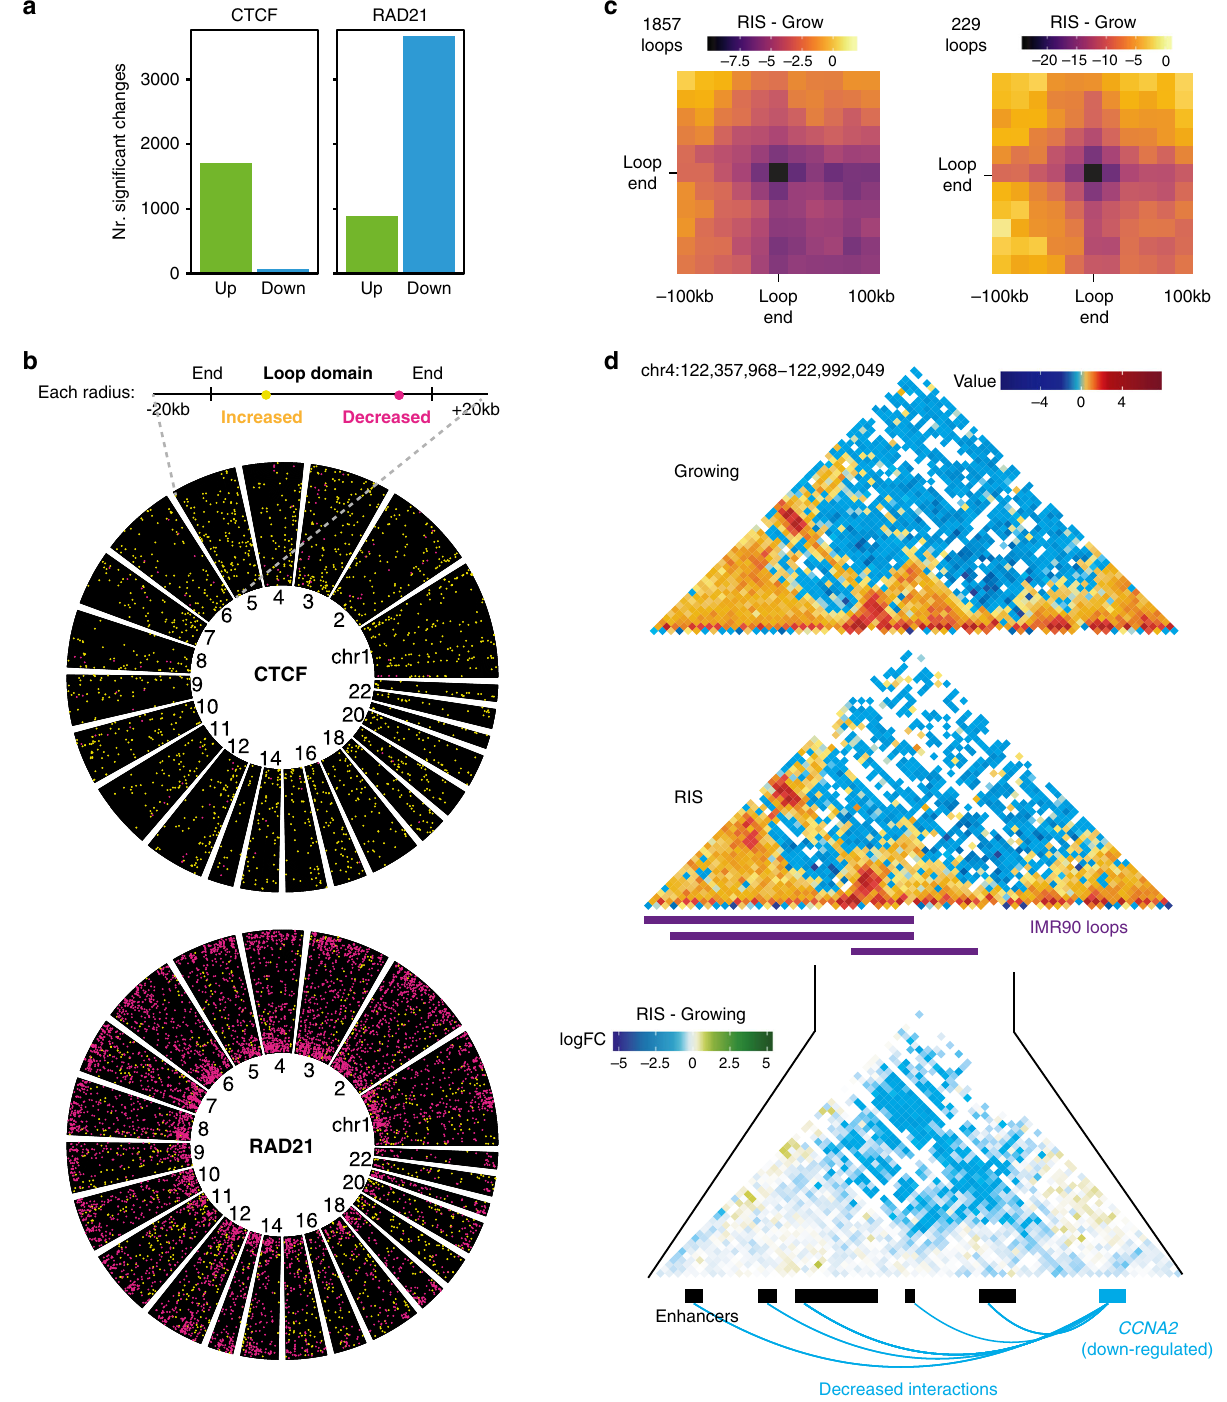
Fig. 3 Correlation between cohesin redistribution and loop rewiring during RIS. a Number of CTCF and cohesin ChIP-seq peaks with increased (green) and decreased (blue) binding in RIS relative to growing (FDR 0.05, differential binding analysis performed with THOR). b Position of CTCF and cohesin binding changes relative to the growing IMR90 loop spans (loops annotated in IMR90 cells by Rao et al. 13 ); each loop is represented as a radial segment linking the two loop anchors with an extra 20 kb at each end. Each signi fi cant binding change is represented as a yellow (increased) or magenta (decreased) dot, for both CTCF and cohesin. c Differential aggregated Hi-C interactions neighbourhoods (20 kb resolution) of all IMR90 loops (1857 loops) that exhibited signi fi cantly decreased cohesin binding at one or both loop ends (left). Compare to the subset (229 loops) with signi fi cantly decreased Hi-C interactions during RIS (right). d Growing and RIS Hi-C matrices (10 kb resolution) centred on the IMR90 loop (from Rao et al. 13 ) consisting of the CCNA2 gene promoter and associated enhancers, as well as the cHi-C differential log-fold change matrix (5 kb resolution) of this loop. Signi fi cantly decreased interactions between the CCNA2 gene promoter and associated enhancers are shown as blue